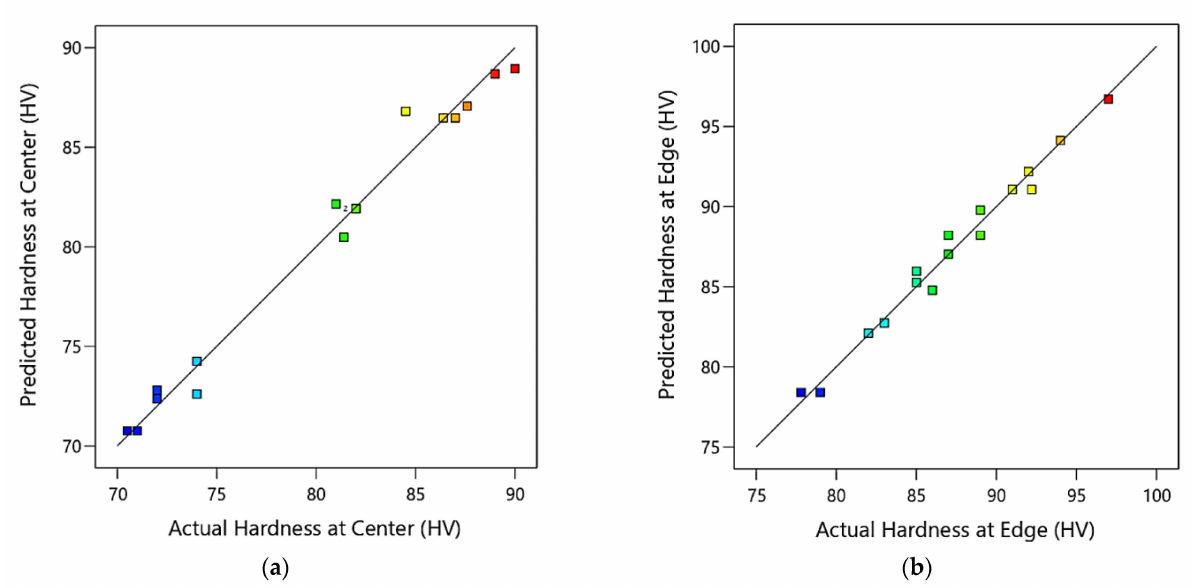
Figure 8. Predicted versus actual values of the ECAP hardness at the center ( a ), and the edge ( b ), where the blue points are for minimum output value and gradually changed to red points for maximum output